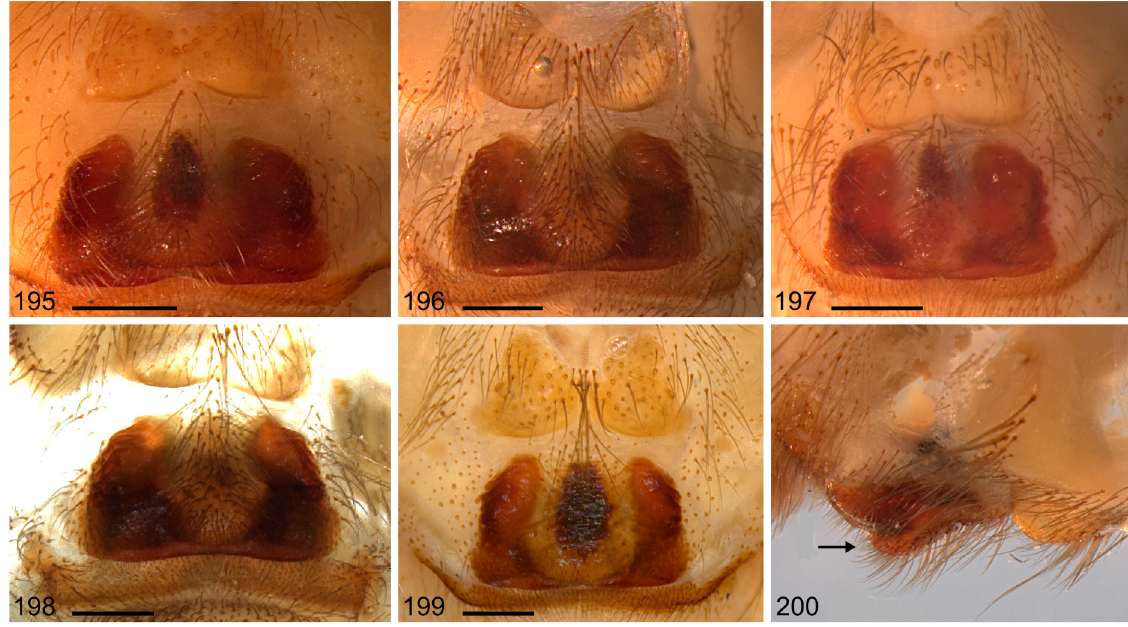
Figs 195–200. Artema sp. c, ♀♀, epigyna, ventral (195–199) and lateral (200) views. 195 .